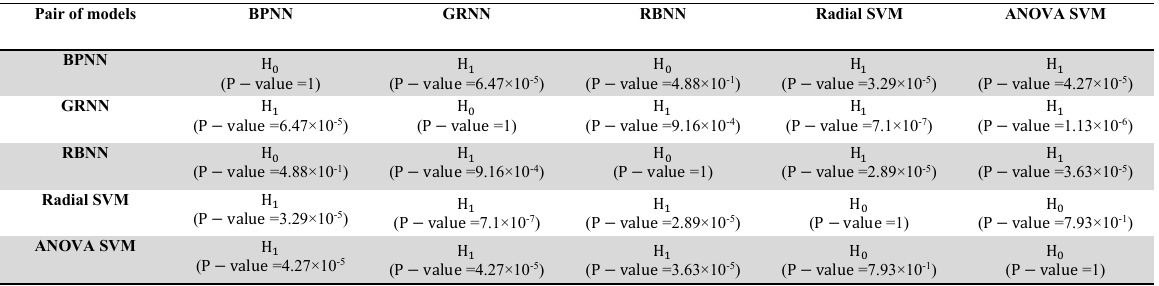
Statistical comparison between the machine learning models for cooling loads prediction based on two- tailed Student’s